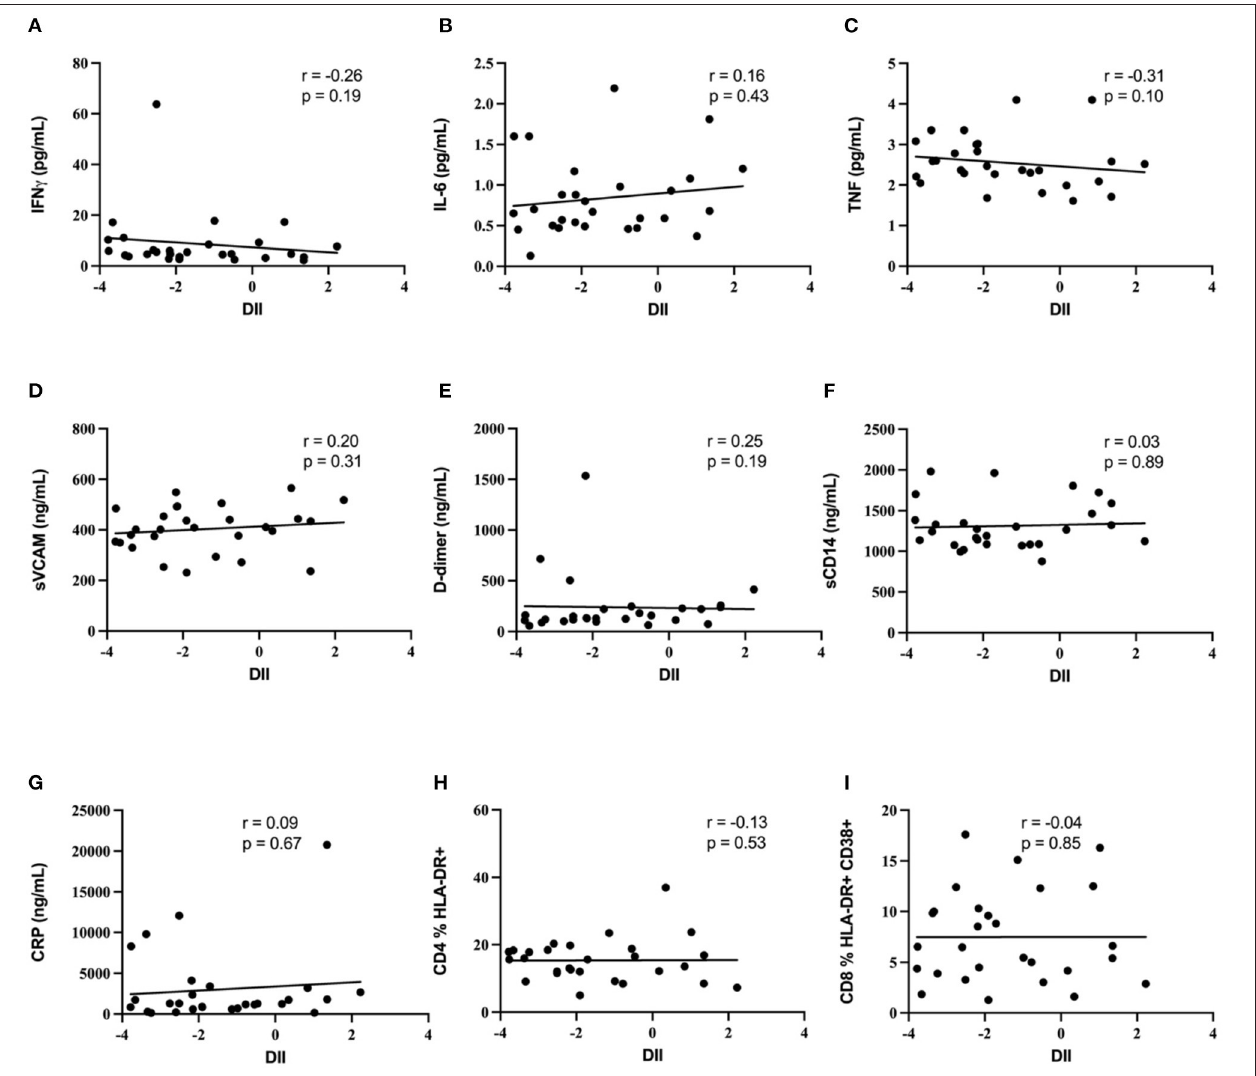
FIGURE 1 | Diet inflammatory index and biomarkers of immune activation. Lack of correlation between diet inflammatory index and biomarkers of immune activation. No correlation was demonstrated between DII and (A) IFNg, (B) IL-6, (C) TNF, (D) sVCAM, (E) D-dimer, (F) sCD14, (G) CRP, (H) blood CD4T cell activation, or (I) blood CD8T cell